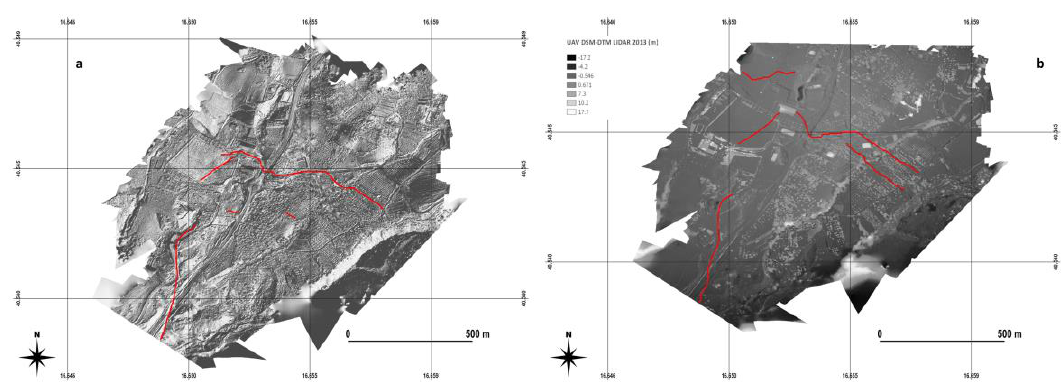
Figure 7. Hillshaded DSM obtained from the UAV surveys and landslide outlines (red lines) ( a ); image that describes the di ff erence between UAV-DSM and LiDAR-DTM (dec2013DTM) in meters, red lines represent landslide outlines ( b ).